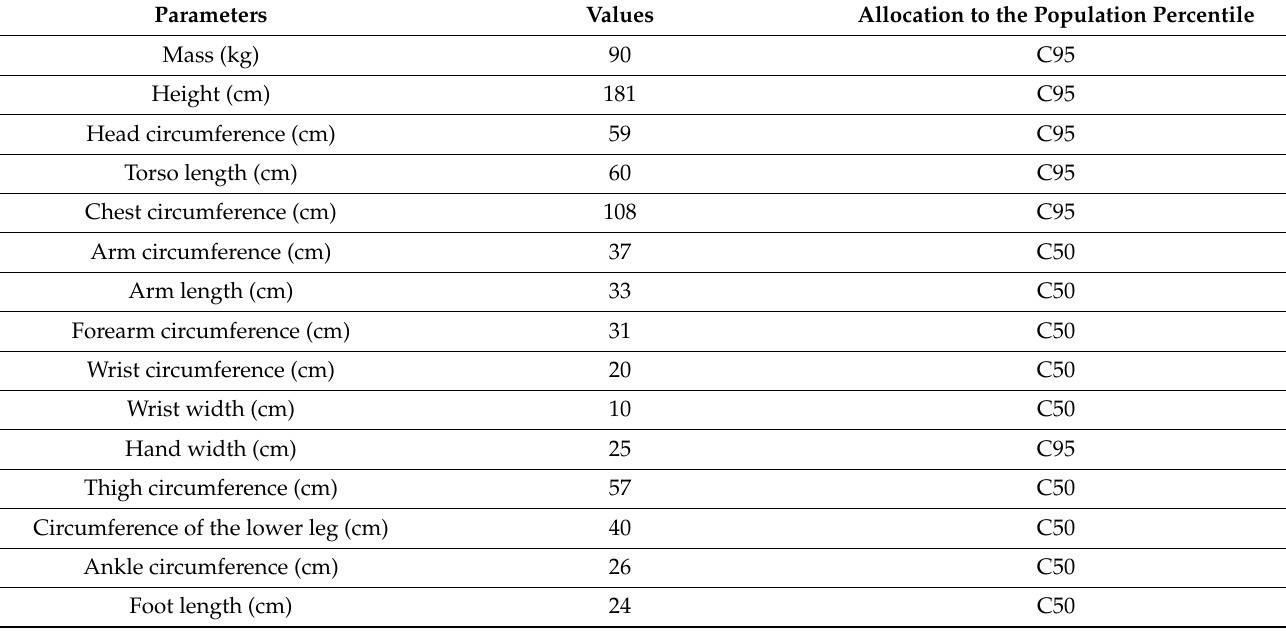
Figure 6. Test stand for crash tests at low speed. Table 2. Volunteer anthropometric